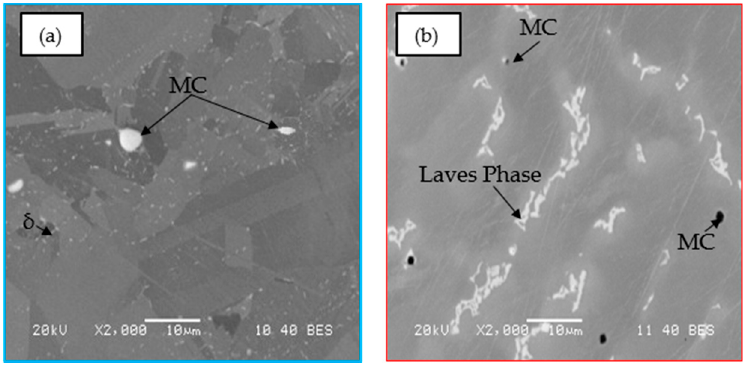
Figure 5. Precipitates in ( a ) Wrought and ( b ) WAAM IN718.